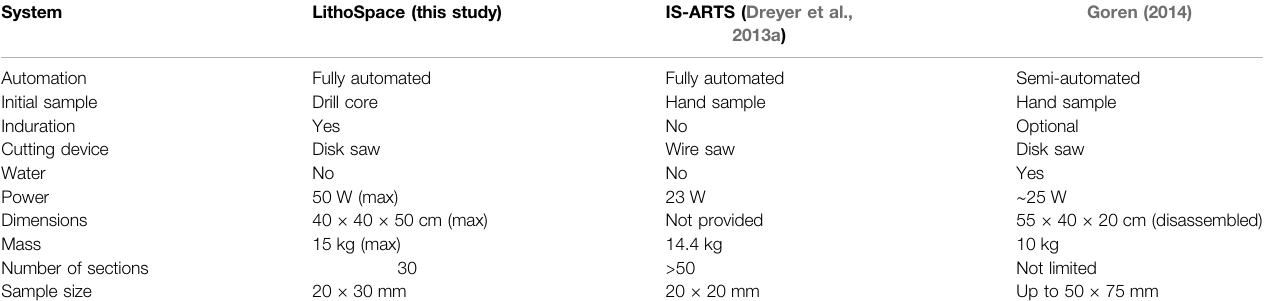
TABLE 1 | Comparison between the envisioned LithoSpace system speci fi cations with those proposed by Dreyer et al. (2013a) (IS-ARTS) and by (Goren, 2014). System